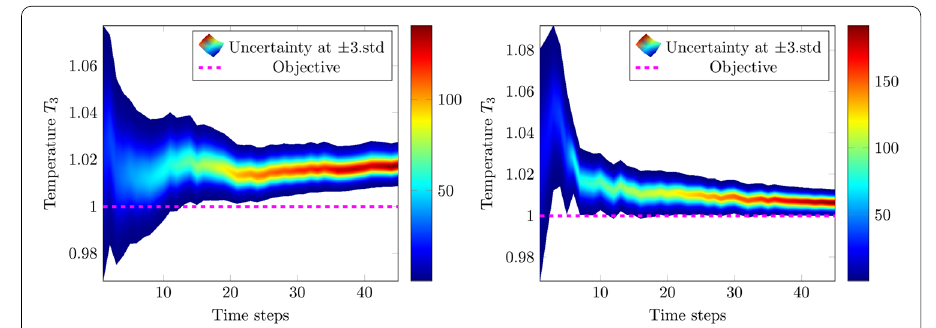
Fig. 15 Evolution in time of T 3 | t without control (left) and with control (right) - Case 1